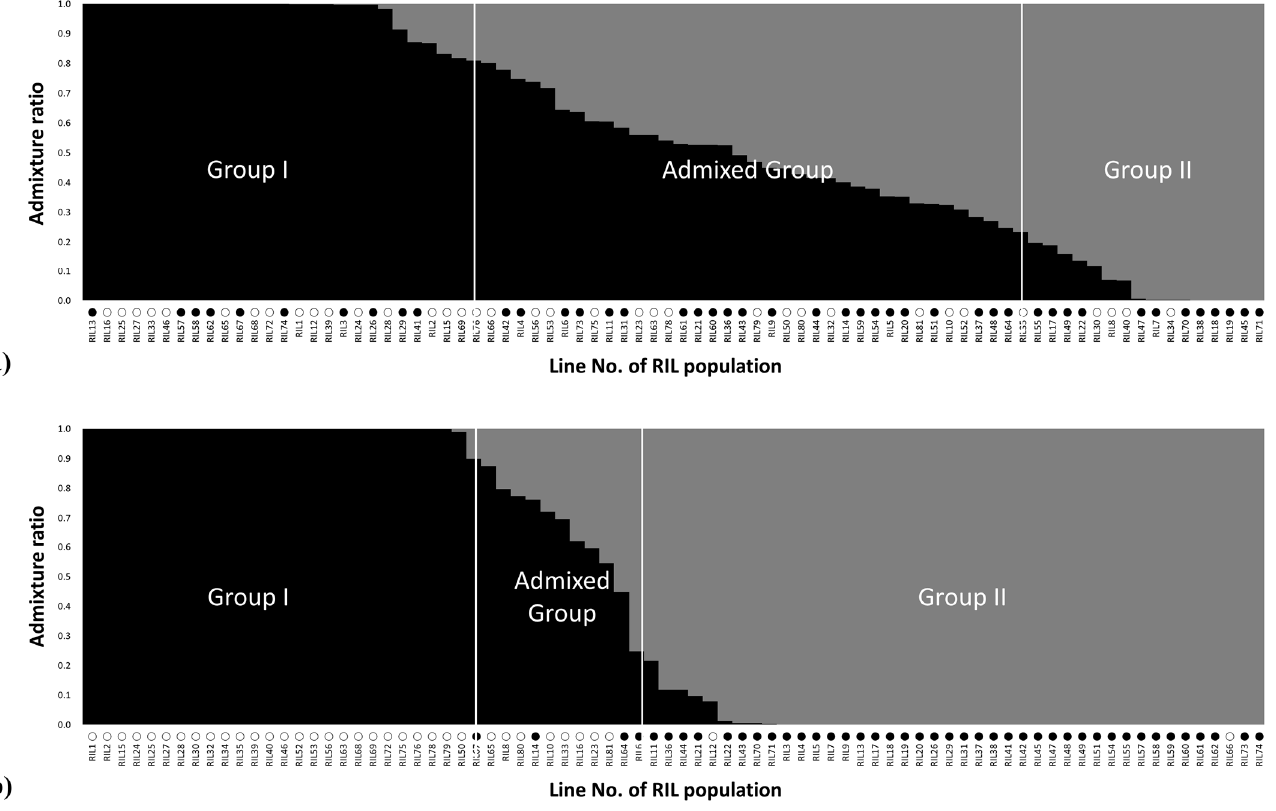
Figure 2. Population structure pattern of 80 RIL population based on SSR and SNP markers for K = 2 and ( a ) 14,968 markers, ( b ) 40 markers by PCA-MLM analysis. ○ : low-amylose lines, ● : high-amylose lines.